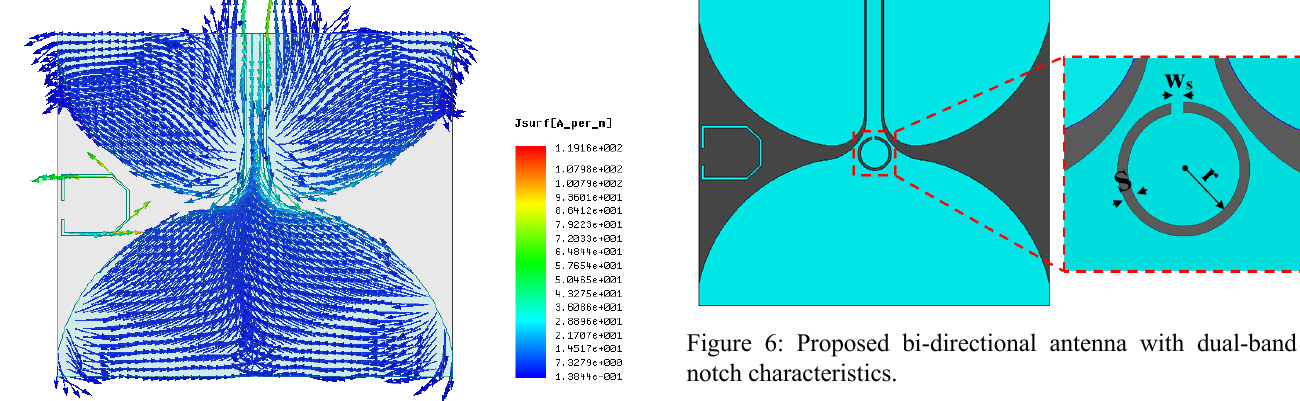
Figure 5: Surface current distribution at f=3.67 GHz of single band-notch proposed antenna.